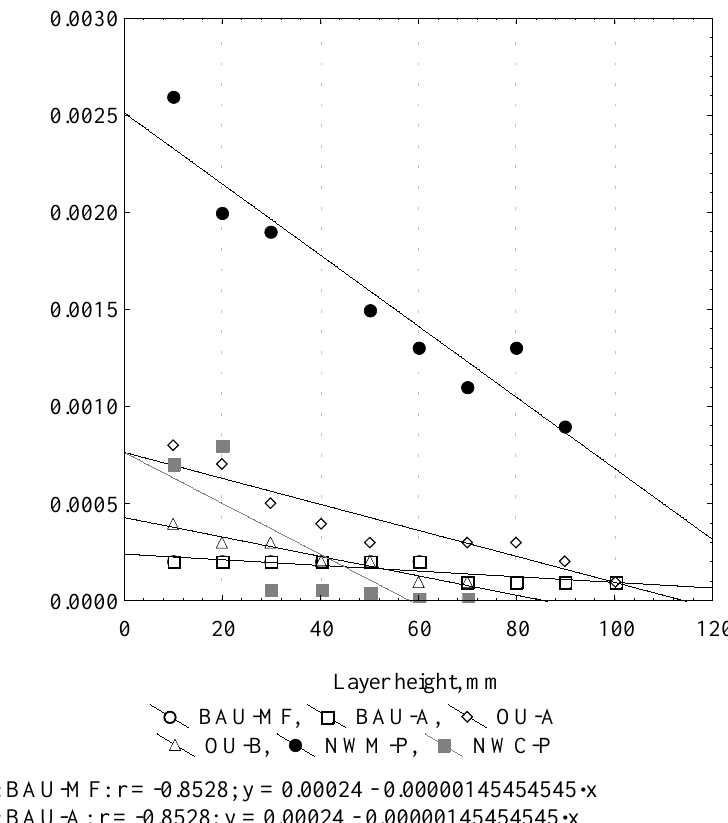
Fig. 9. Dependence of chlorophyll and red pigments content in rutin samples on adsorbent layer